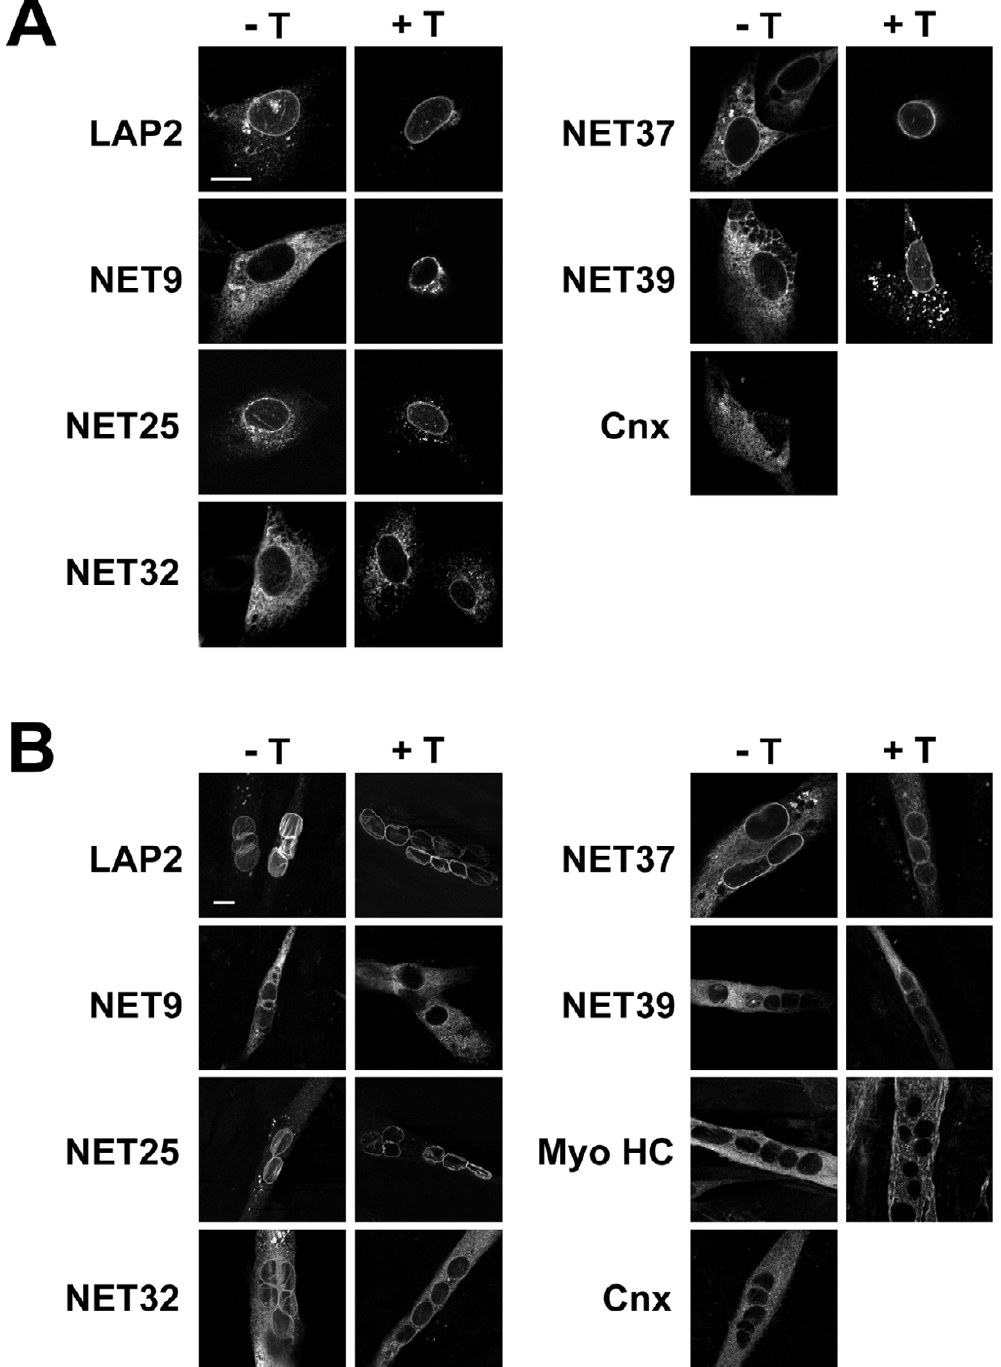
Figure 6 Nuclear envelope targeting of NETs up-regulated in C2C12 differentiation . V5 epitope tagged NETs, LAP2 β and cal- nexin (Cnx) were transiently transfected into C2C12 cells. Cell were left untreated (- T) or extracted with 1% Triton X-100 (+ T) before fixation and immunofluorescence staining. Shown are representative images from (A) undifferentiated C2C12 cells, (B) differentiated C2C12 cells. All epitope-tagged calnexin was removed by Triton X-100 pre-extraction (not shown). Scale bar: 20 µ